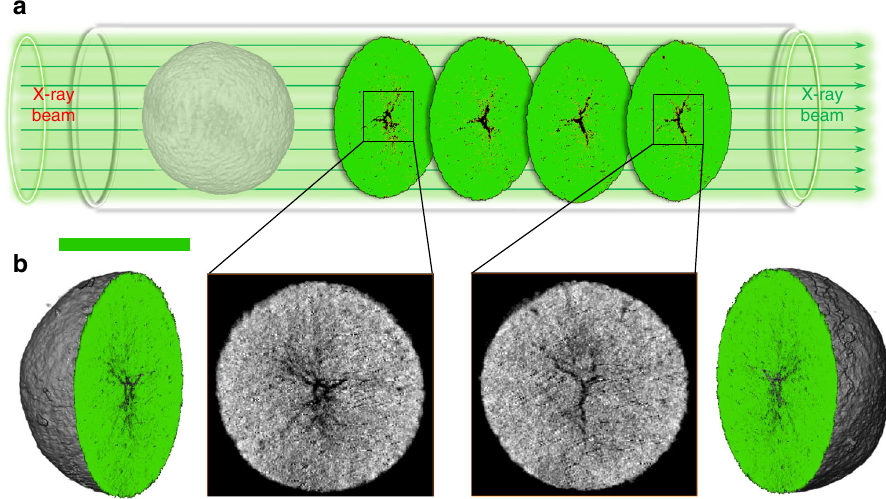
Fig. 4 X-ray nanotomography of the cycled cathode particles in the ASSLBs. ( a ) 3D renderings and virtual slices of the polycrystalline NCM particle structure after 50 cycles. ( b ) Representative slices through different depths of the particle. Scale bar, 10 μ